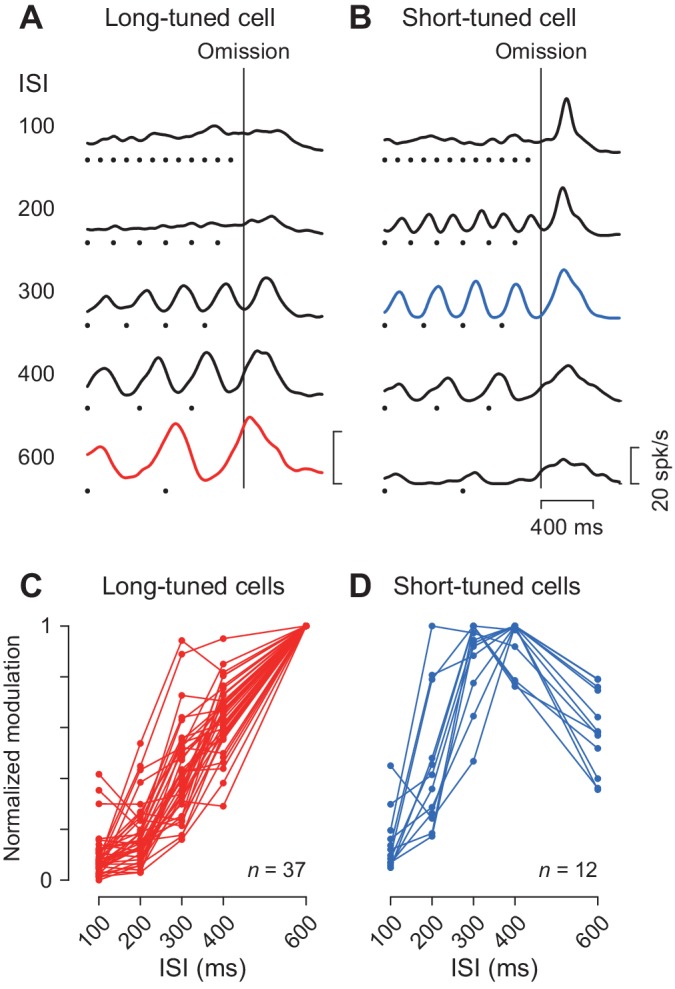
Duration preference.(A, B) Spike density profiles of two example neurons for different ISIs. Data are aligned with the stimulus omission (vertical black line). Black dots below the traces indicate stimulus timing. Each panel plots a long-tuned neuron (A) and a short-tuned neuron (B). (C, D) Duration tuning for individual neurons. Data points connected with lines indicate the normalized firing modulation for each neuron. Note that the majority of neurons (75%, 36/48) steadily elevated the magnitude of firing modulation as the ISI increased (C). Note also that most short-tuned neurons showed a preference for either 300 or 400 ms ISI but never for 100 or 200 ms (D).10.7554/eLife.48702.009Figure 4—source data 1.Numerical data for Figure 4.